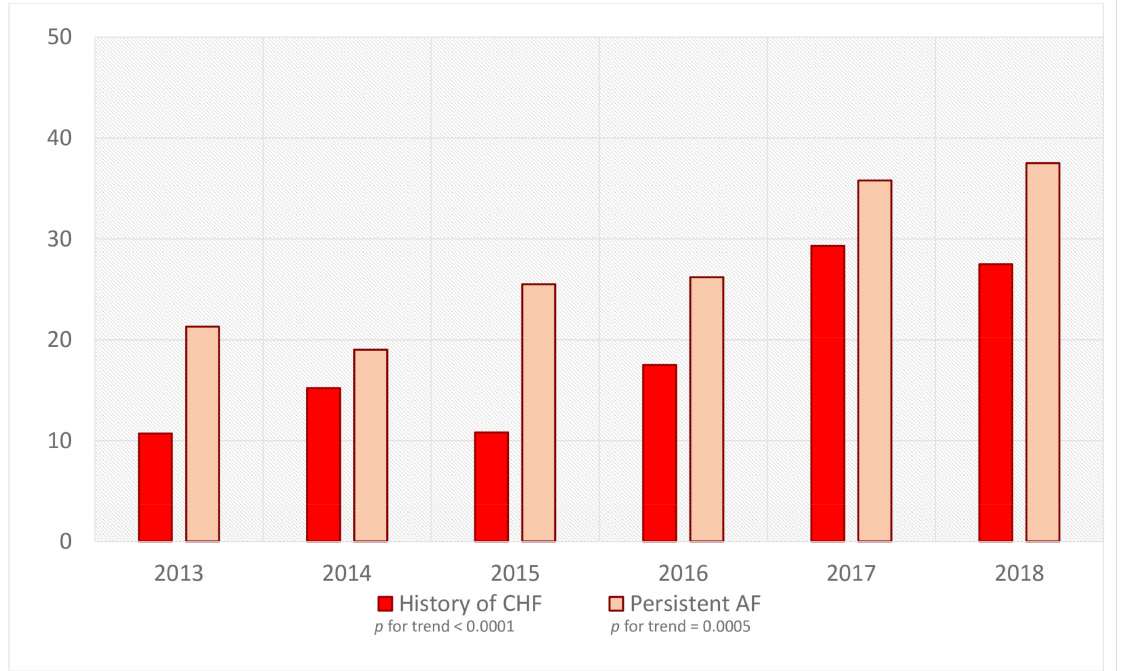
Figure 3. Percentage of patients with persistent AF and CHF burden undergoing ablation in our center in consecutive years. Abbreviations: AF—atrial fibrillation, CHF—chronic heart